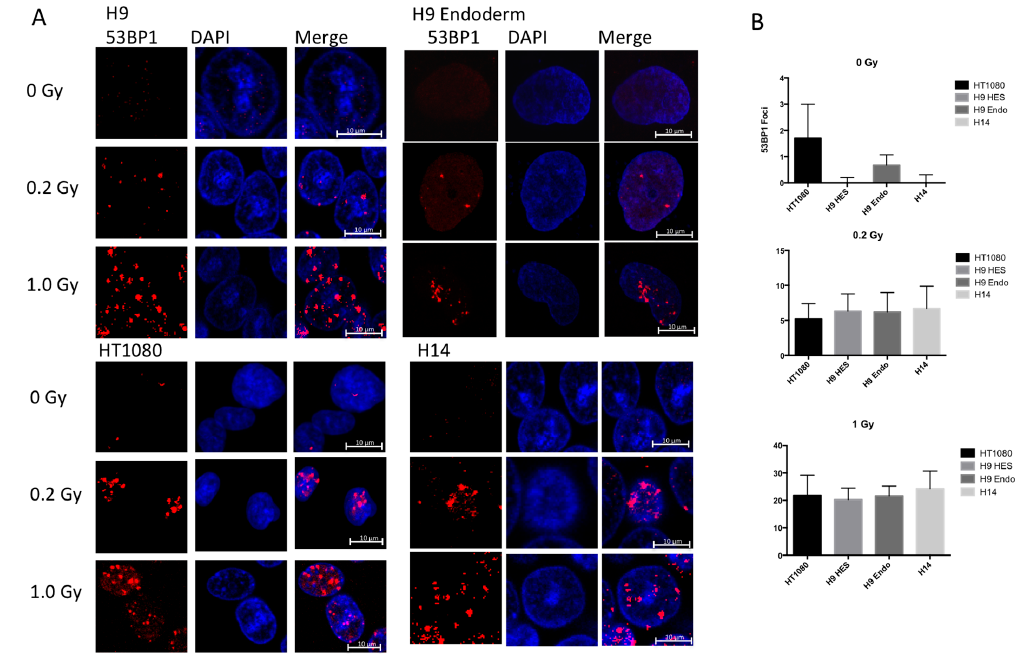
Figure 5. 53BP1 foci formation after IR exposures. ( A ) Maximum intensity projection confocal microscopy images staining with 53BP1 antibody ( red ) and DAPI ( blue ); ( B ) Measured numbers of foci per cells for various cell lines after exposure to 0, 0.2 and 1.0 Gy.